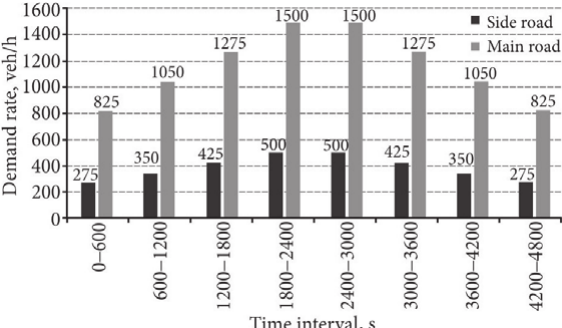
Fig. 6. Dynamics of general traffic demand rate